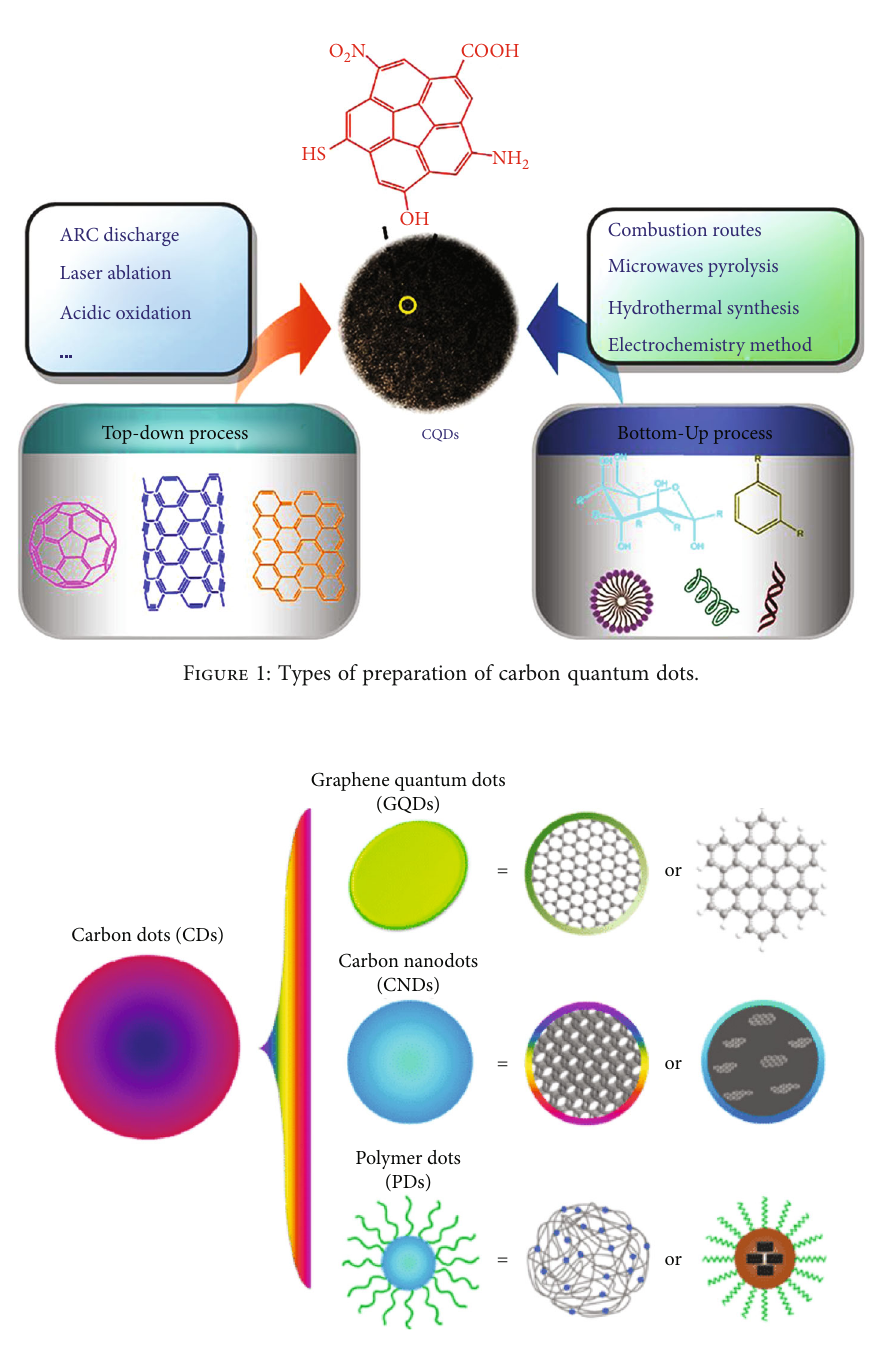
Figure 2: Types of carbon